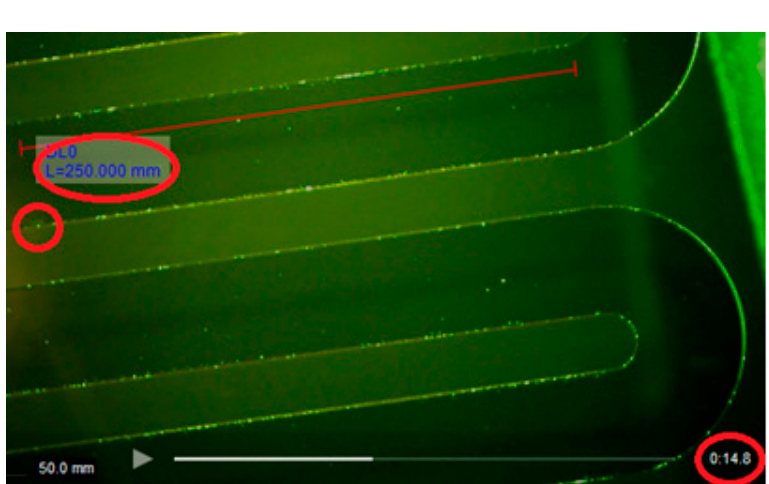
Figure 3. Dino Lite 2.0 software with evidence of fixed distance of 250 mm and a time interval of when microsphere travels the distance.